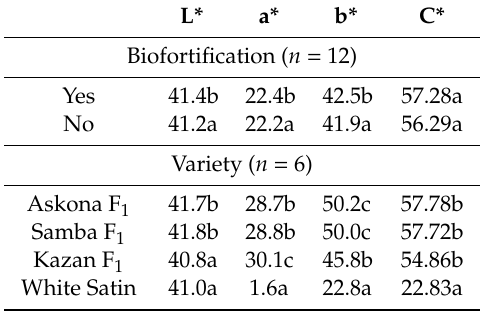
Table 4. Color parameters of carrot juice depending on the biofortification of carrots and their varieties. L* a* b* C* Biofortification ( n = 12) Yes L*—color lightness; a*—contribution of green or red color; b*—contribution of blue or yellow color; C*—chroma. The same letters in the columns set no di ff erences at p <